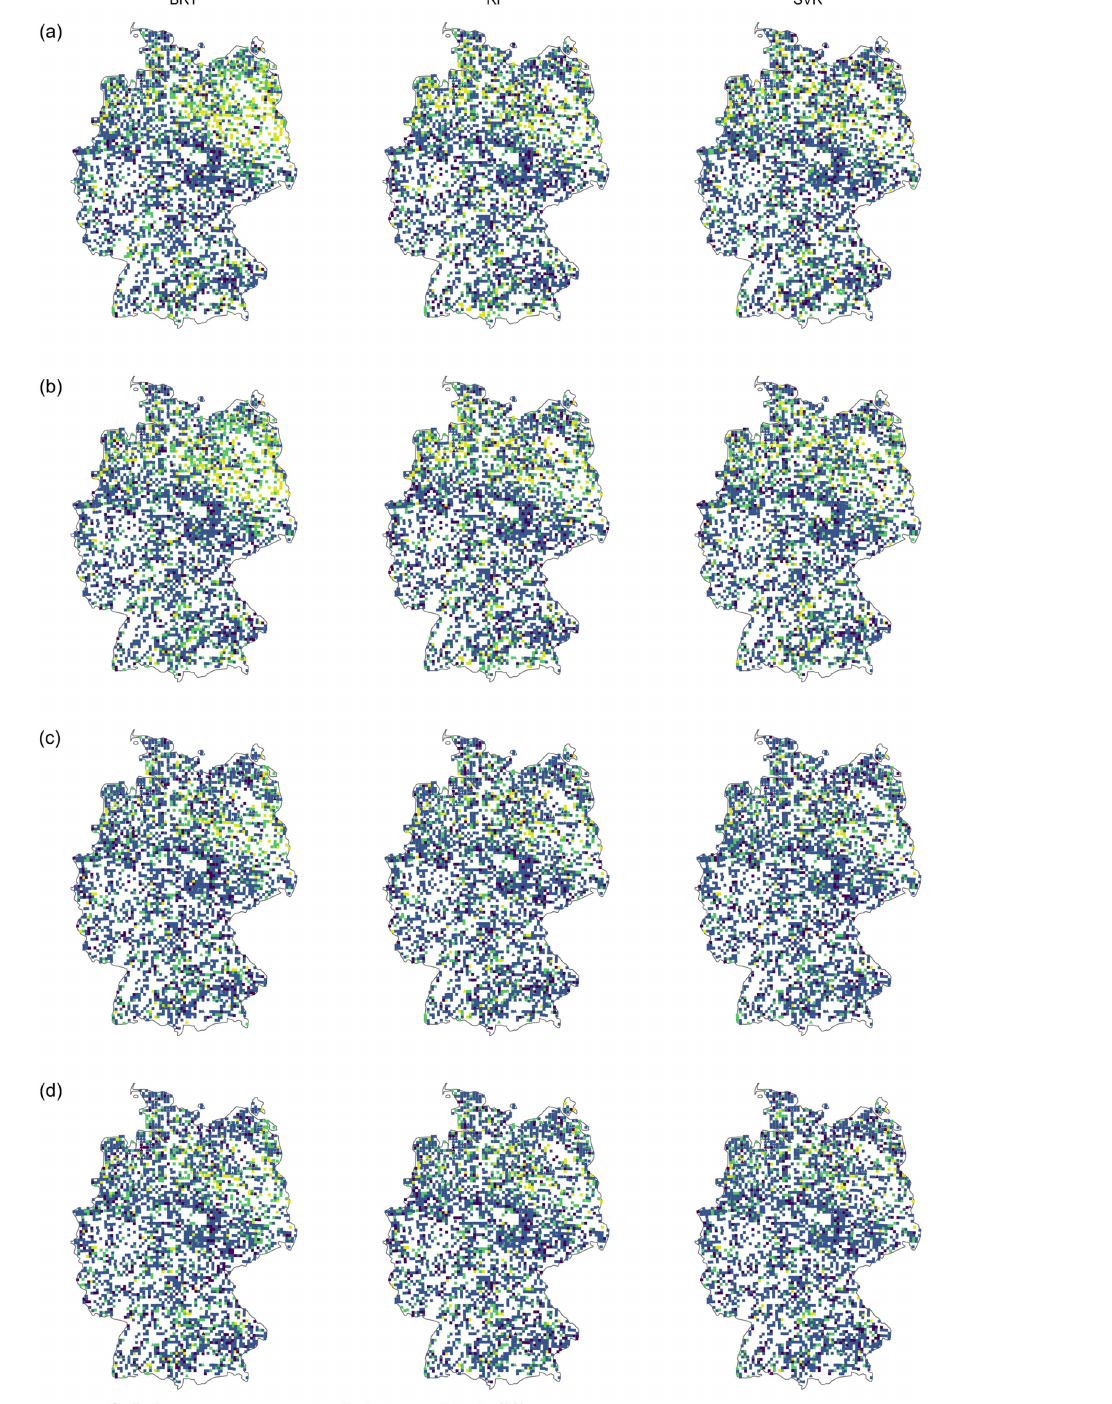
Figure 3. Spatial distribution of relative residuals for (a) the AP1 approach, (b) the AP1L approach, (c) the AP2 approach, and (d) the AP2L approach. The abbreviations used in the figure are as follows: BRT – boosted regression trees, RF – random forest, and SVR – support vector